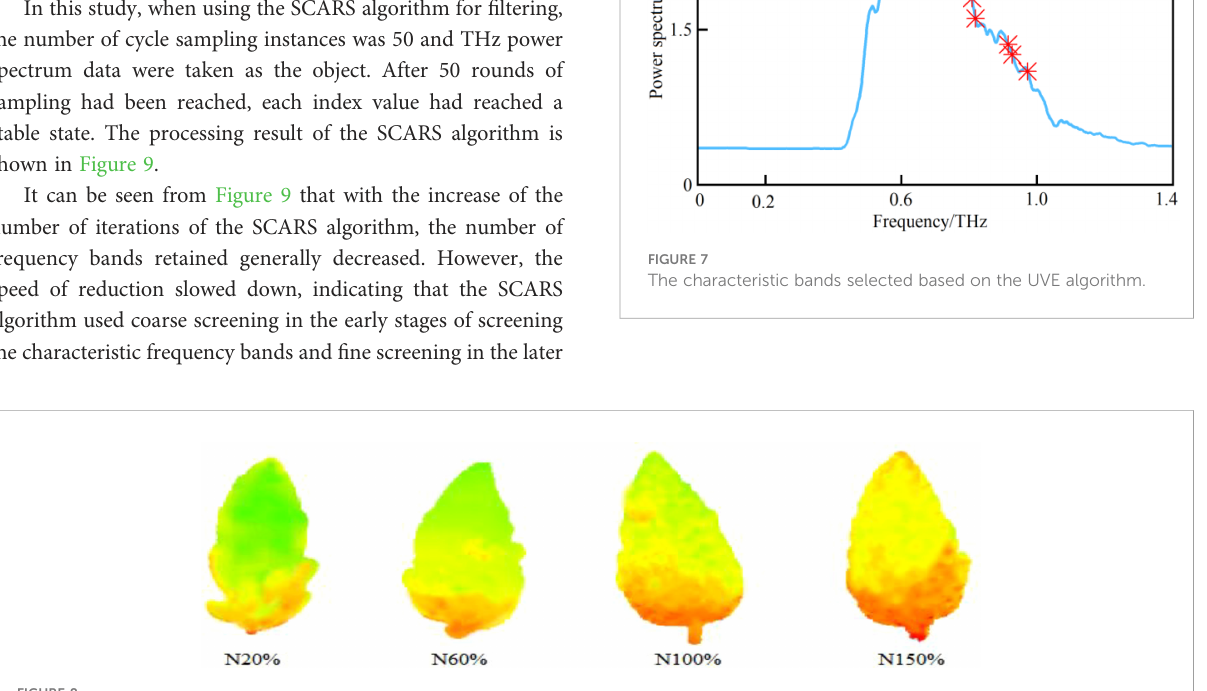
FIGURE 8 THz images of leaves with different nitrogen levels in the characteristic frequency bands screened by the UVE algorithm.